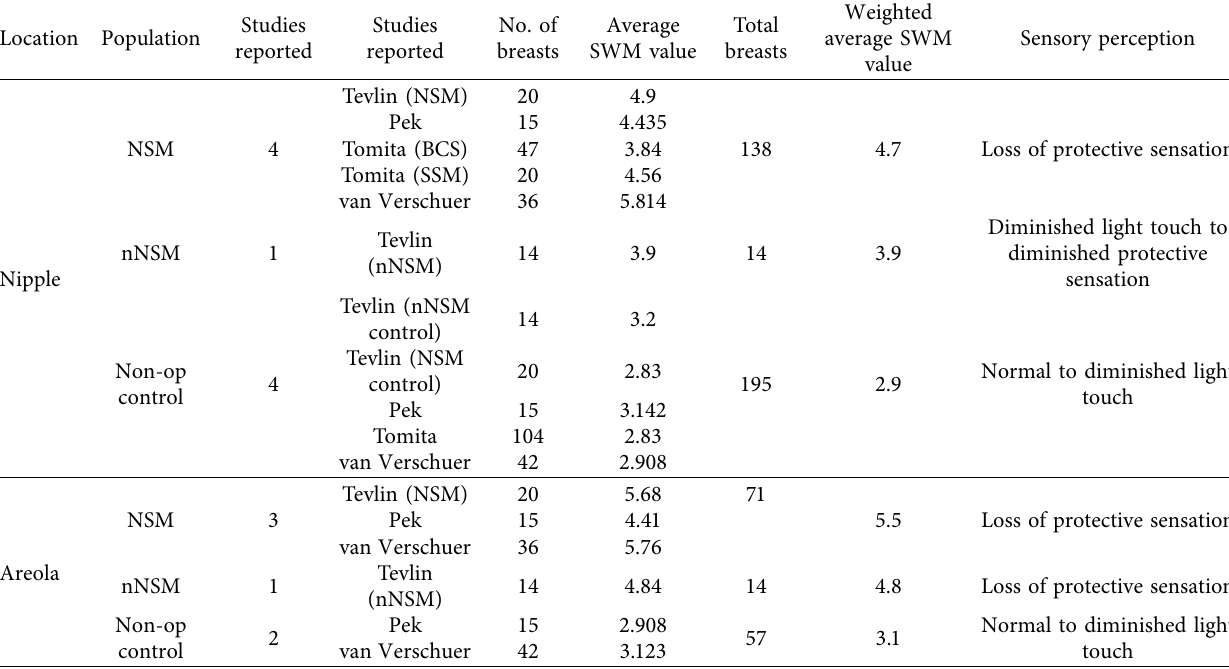
Table 3: Objective outcomes and sensory